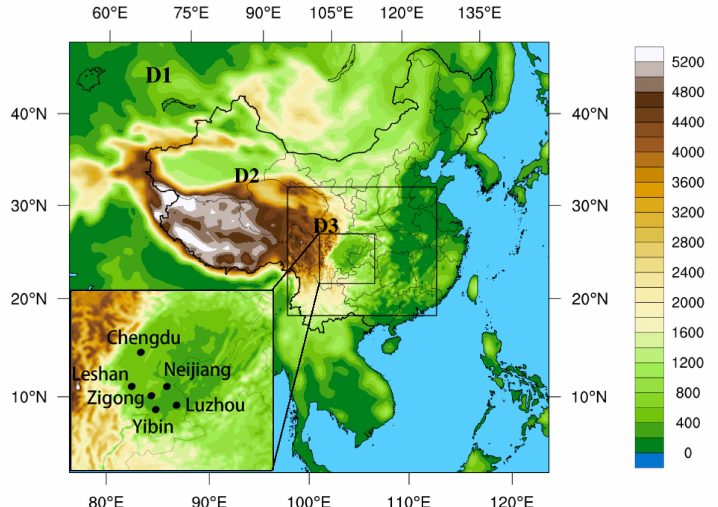
Figure 1. Distribution diagram of simulation area settings (D1: Domain 1; D2: Domain 2; D3: Domain 3; The shaded map is for terrain height from sea level); D3 also includes the locations of Chengdu, Leshan, Luzhou, Neijiang, Yibin and